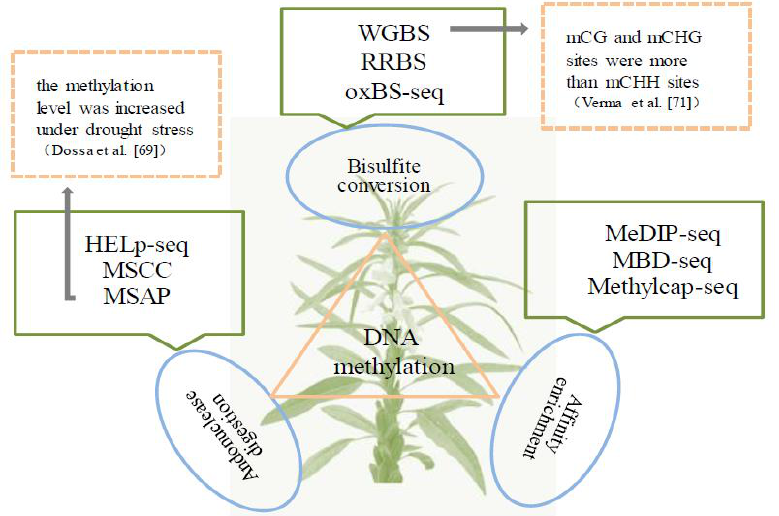
Figure 3. The main methods of DNA methylation in sesame. It mainly contains whole genome bi- sulfite methylation sequencing (WGBS), oxidative bisulfite sequencing (OxBS-seq), reduced representation bisulfite sequencing (RRBS), methylation DNA immunoprecipitation sequencing (MeDIP-seq), HpaIItiny fragment enrichment by ligation-mediated PCR(HELP-seq), and so on.